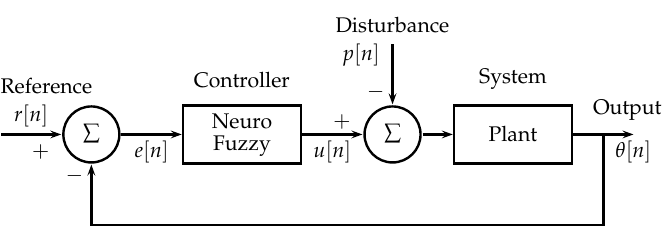
Figure 9. General diagram of the control